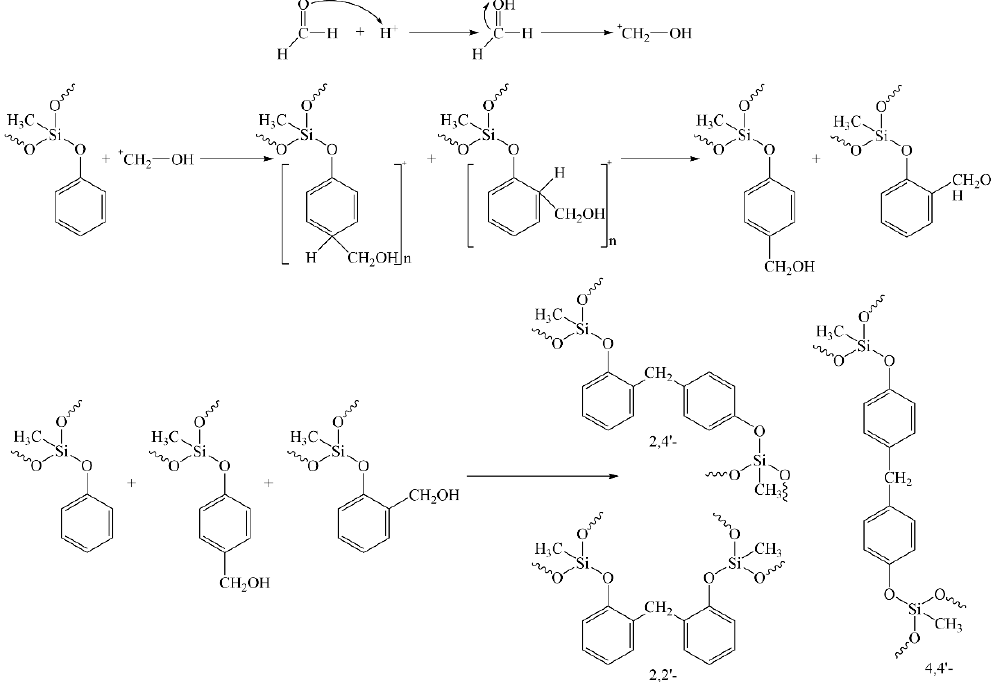
Figure 4. Infrared spectra of methyl-trimethoxy-silane (MTMS), methanol and reaction products of MTMS with phenol. The infrared spectrum analysis revealed the presence of methanol, a by-product of the transesterification reaction between MTMS and phenol, and unreacted MTMS in the low boiling point products generated during the reflux stage. According to the mechanism of transesterification for the synthesis of methyl-trimethoxy-silane intermediates, the pro- duction of methanol indicates the occurrence of the transesterification reaction and the formation of methylphenoxyilane intermediates. Figure 5 displays the results of infrared spectroscopy tests conducted on silicone- modified phenolic resins with MTMS content of 0 (i.e., phenolic resin without MTMS modification UMPR) and with MTMS content of 40% phenol mass (SMPR). In the UMPR infrared spectrum test results, a stretching vibration peak of hydroxyl emerged at 3296 cm − 1 , a stretching vibration peak of the C-H bond appeared at 3030 cm − 1 and 2911 cm − 1 , and a stretching vibration absorption peak of the benzene ring skeleton appeared at 1597 cm − 1 and 1441 cm − 1 . In the SMPR infrared spectrum test results, the stretching vibration peak of hydroxyl appeared at 3299 cm − 1 , the stretching vibration peak of the C-H bond appeared at 3017 cm − 1 and 2909 cm − 1 , and the stretching vibration absorption peak of the benzene ring skeleton appeared at 1601 cm − 1 and 1550 cm − 1 . Moreover, the stretching vi- bration peaks of C-O bonds between the benzene ring and phenolic hydroxyl groups were detected at 1231 cm − 1 and 1226 cm − 1 for UMPR and SMPR, respectively. There is no